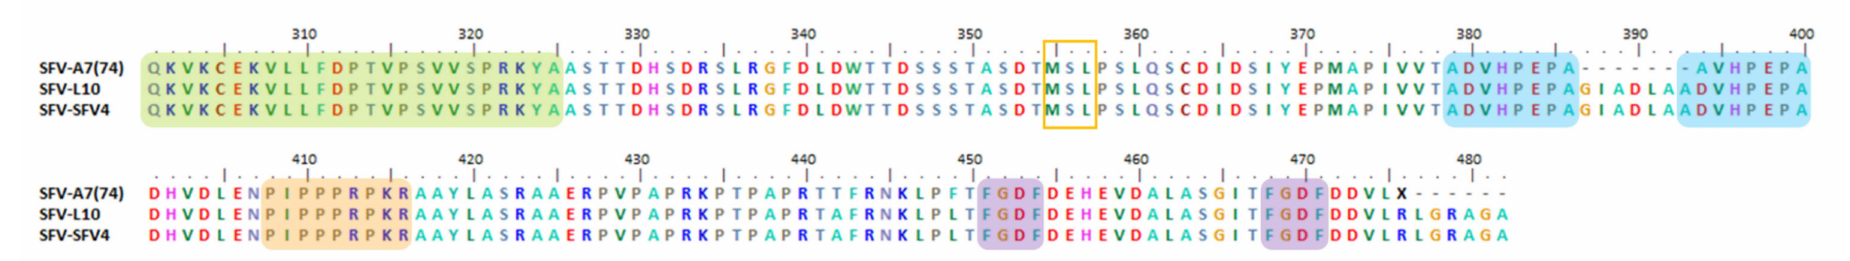
Figure 5. Important motifs and mutation events in SFV nsP3 HVD. The HVD starts at position 325. It has an extended P-rich region at position 408–416 (peach), and two FGDF-like motifs at positions 451–454 and 468–471 (purple). A7(74) has a 7 aa deletion at position 387–393. The duplicate motif ADVHPEPA flanks the GIADLAA deletion motif at positions 379–386 and 393–400 (blue). A predicted conserved motif, MSL, can be observed at position 355–356 (orange